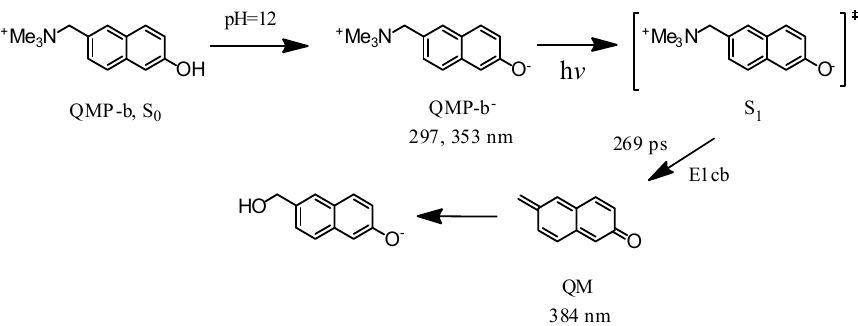
Figure 1. ( a ) QMP-b UV-Vis spectra obtained in mixed aqueous solutions with different pH values. ( b ) UV-Vis spectrum (top) and the computed deprotonated species of QMP-b electronic spectrum (bottom) using the TD-B3LYP/6-311G(d,p)